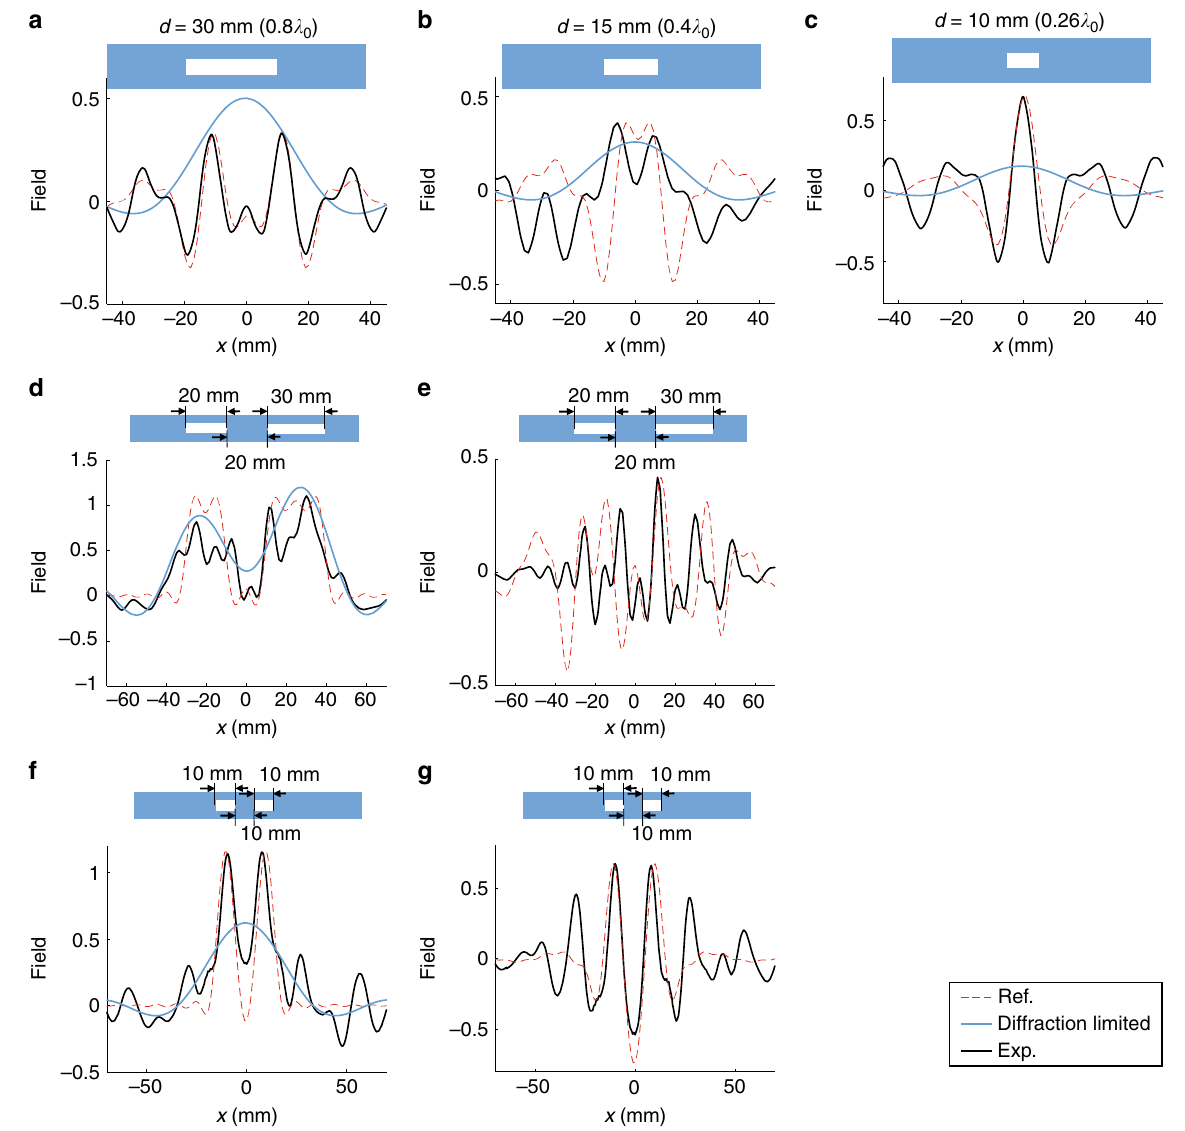
Fig. 7 Subwavelength imaging and edge detection for 1-D single slits and double slits. a – c Edge images for a single slit of size 30 mm ( a ), 15 mm ( b ), and 10 mm ( c ), respectively. d The full image of a double-slit object with 20 mm and 30 mm slit widths and 20 mm edge-to-edge distance. e The edge image of the 20 – 30 mm double slits. f The full image of a double-slit object with 10 mm and 10 mm slit widths and 10 mm edge-to-edge distance. g The edge image of the 10 – 10 mm double slits. In ( a – g ), black solid lines are experimental measurements, blue solid lines are diffraction-limited results from empty waveguide, and red dashed lines are theoretical Methods Experimental setup . As shown in Fig. 5a, the slit to be imaged is put in contact with the HRs in the transmitter (len1, lens2 and lens3) or the entrance of the empty waveguide (lens0). The left and right sides of the waveguide are covered by sound absorbing foam. A sound speaker located 20cm (around fi ve wavelengths) away from the slit sends eight periods of 9000 Hz sound wave. The wave incidents on the slit and the scattered wave from the slit enters the transmitter. At the receiver, a microphone (PCB 130F20) scans the sound fi eld along the x direction at the exit of the HR arrays. The scanning has resolution of 1.25mm and in total 180 points (22.5 cm) are scanned. At each scanning point, 0.01 s (90 periods for wave of frequency 9000 Hz) of the sound wave is recorded. Experimental data normalization . A time window of 10 periods is applied to each directly measured signal to obtain the portion of sound signal that comes from the imaging system in order to eliminate the interference of re fl ected wave from sur- rounding environment (the lab walls, table surface, etc.) and the multiple re fl ec- tions inside the waveguides. By taking the time domain Fourier transform of the time-windowed signals, the complex values of the 9000 Hz components at all